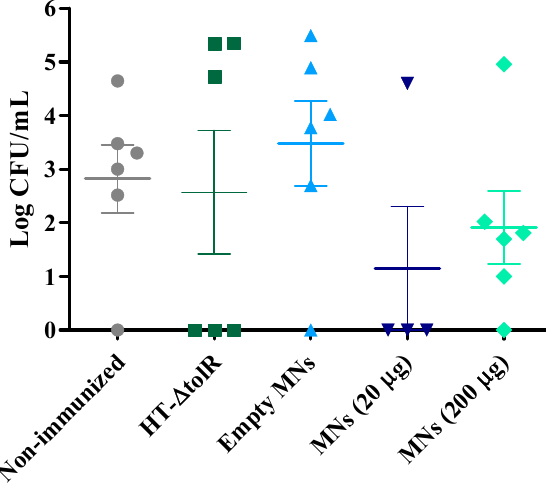
Figure 8. Protection against colonization of Shigella flexneri . Mice were immunized with one single dose of 20 µ g of free HT- ∆ tolR (intranasally) or 20 or 200 µ g of HT- ∆ tolR embedded in Gantrez ® AN119 MNs (six mice per group). Results are presented as degree of colonization (Log CFU / mL) in lungs. Non-immunized and empty-MN groups were included as controls. Error bars represent SD.